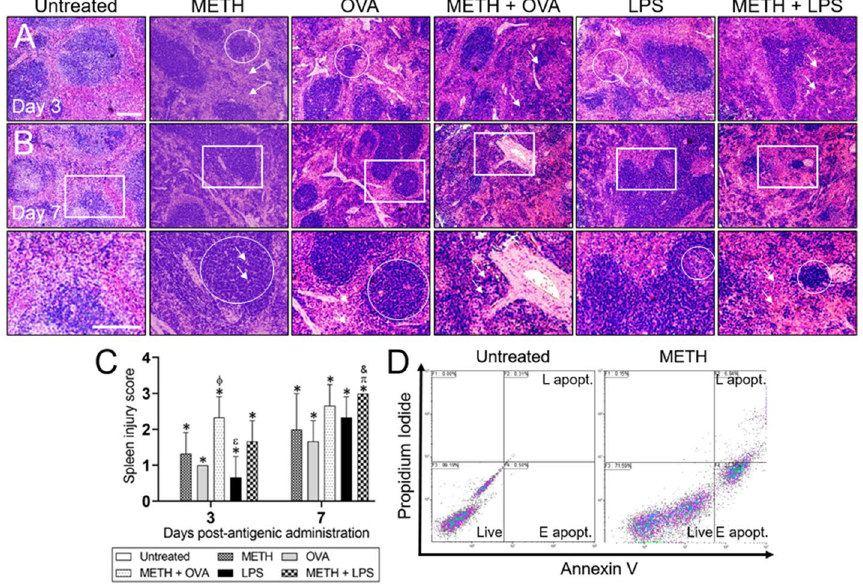
Figure 2. Increasing and prolonged doses of METH damage the spleen of C57BL/6 mice. (A) Representative 10 × magnification of H&E stained sections of splenic tissue excised from untreated, METH, OVA, METH + OVA, LPS, and METH + LPS-treated mice after 3 (upper panel) and 7 (middle panel) days post-Ag administration are shown (scale bar, 100 μm). (B) Magnified (40 ×) white boxes of splenic tissue after 7 days (lower panel) post-Ag administration (scale bar, 100 μm). For panels A and B , circles and arrows indicate specific morphological changes explained in the result section. (C) The spleen injury score (SIS) was evaluated blindly by two independent investigators. Each bar indicates the average score for 5 fields per image per investigator and error bars indicate STDEV. Bars without error bars denote conditions with no variability in SIS. Symbols (*, π, , &, and ε) indicate P value significance ( P < 0.05) calculated using ANOVA and adjusted by use of the Tukey’s post-hoc analysis. *, π, , and & indicate significantly higher SIS than in the untreated, METH, ϕ OVA, and LPS-treated groups, respectively. ε indicates significantly lower SIS than in the METH + OVA-treated ϕ group. The spleens of untreated mice did not show any injury after 3- and 7-days post-Ag challenge, therefore, a bar for the group (SIS = 0) is not present. (D) Splenocytes excised from untreated and METH-treated mice ( n = 5 per group) were analyzed for apoptosis by flow cytometry after being stained with annexin V-FITC together with propidium iodide (PI); representative plots are presented. The percentages of viable (live), early apoptotic (E apopt.) and late apoptotic (L apopt.) cells are